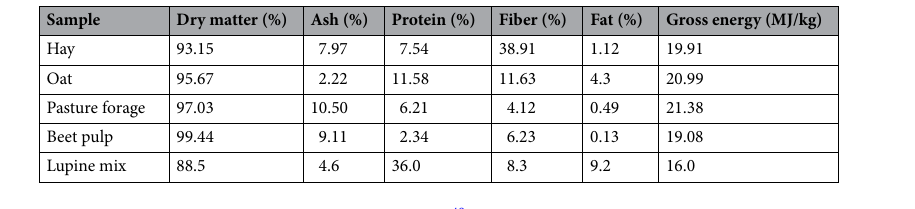
Table 6. Chemical composition of the fodder 48